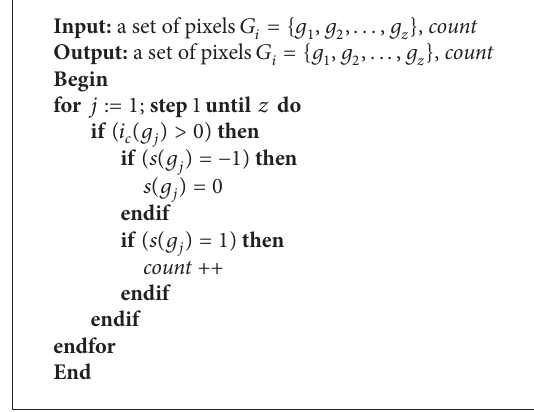
Algorithm 5: PixelsUpdate